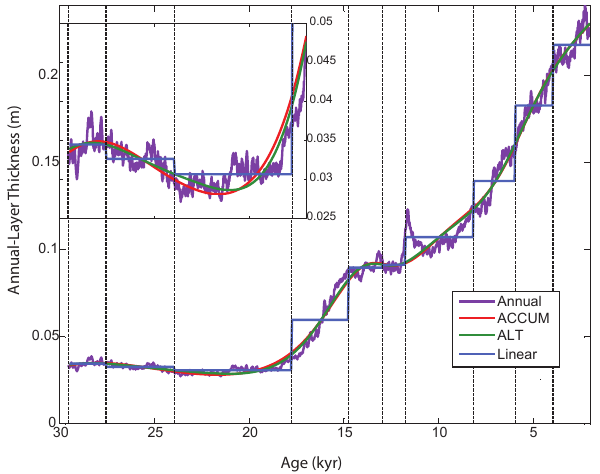
Figure 4. Age differences between the interpolation methods and the WDC06A-7 timescale. Yellow shading is the accumulated un- certainty of WDC06A-7 from the closest tie point (WAIS Divide Project Members,